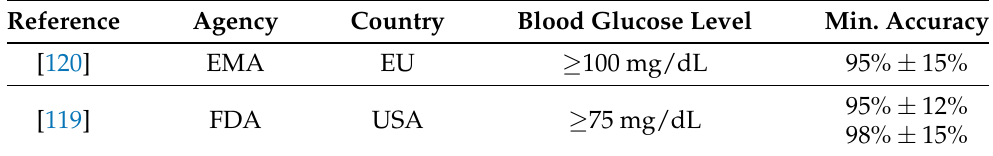
Table 8. Criteria for FDA and EMA according to